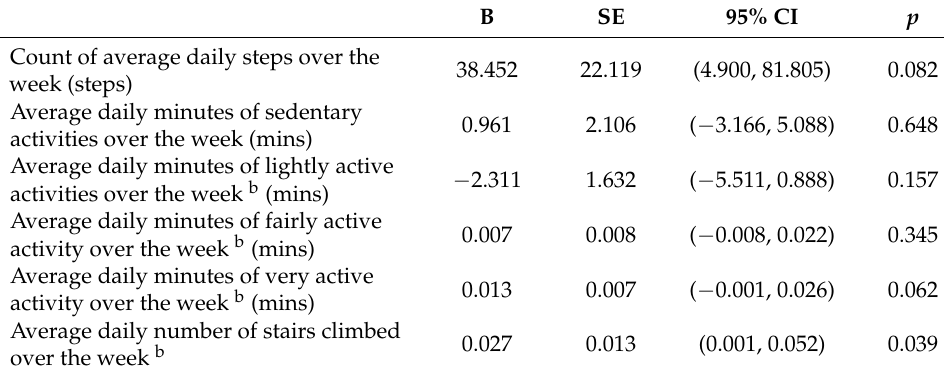
Table 3. Baseline to 24-week changes in the data collected by the WAT a